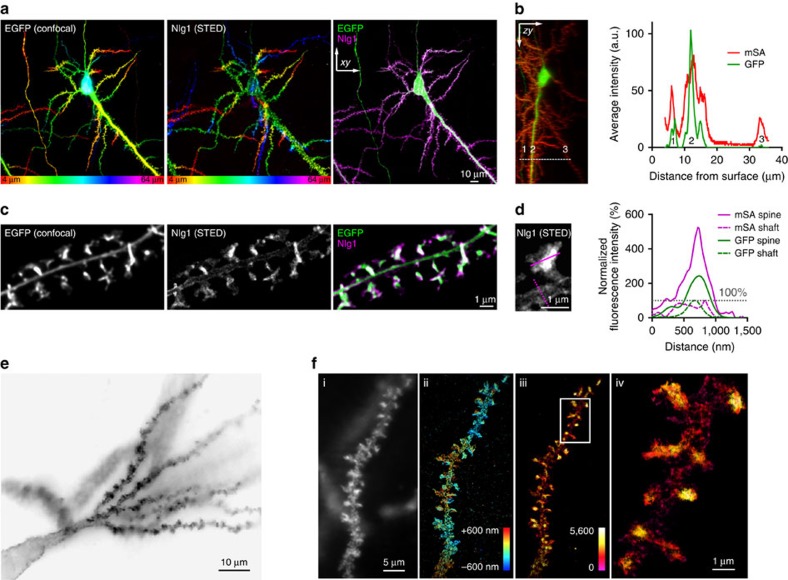
Super-resolution imaging of AP-Nlg1 in organotypic hippocampal slices.(a) Confocal (EGFP, left), STED (mSA-Atto 647N, middle) and merged (right) images acquired from live neurons expressing GFP, AP-Nlg1 and BirAER in organotypic hippocampal slices. Images are projections of a z-stack of 60 planes taken by 1-μm increments and colour-coded with respect to sample depth. (b) Linescan measurements of mSA-Atto 647N and GFP staining along the z axis. The reduction in mSA-Atto 647N intensity with the sample depth likely reflects reduced laser penetration rather than weaker staining, since the GFP signal also decreases with depth. (c) High-magnification deconvoluted STED projection of mSA-labelled Nlg1 in a hippocampal slice shows the accumulation of Nlg1 at dendritic spines. (d) Linescans of GFP and mSA-Atto 647N fluorescence intensity in the shaft membrane and in a dendritic spine normalized to the respective fluorescence of GFP and Atto 647N in the shaft. (e) Wide field image of mSA-Alexa647 selectively labelling one neuron expressing GFP, AP-Nlg1 and BirAER, a few microns deep from the surface of an organotypic brain slice. (f) Astigmatic-based 3D dSTORM imaging in an organotypic brain slice from Nlg1 KO mice: (i) wide field image of mSA-Alexa647-labelled AP-Nlg1. (ii) 3D dSTORM-reconstructed image of a dendritic segment based on 1,038,506 single-molecule localizations from 64,000 images. The image is colour-coded with respect to the z distance (−600 to +600 nm). (iii) Normalized localization detection maps integrated within z=±400 nm. (iv) Magnified view of iii showing the enrichment of Nlg1 in dendritic spines.